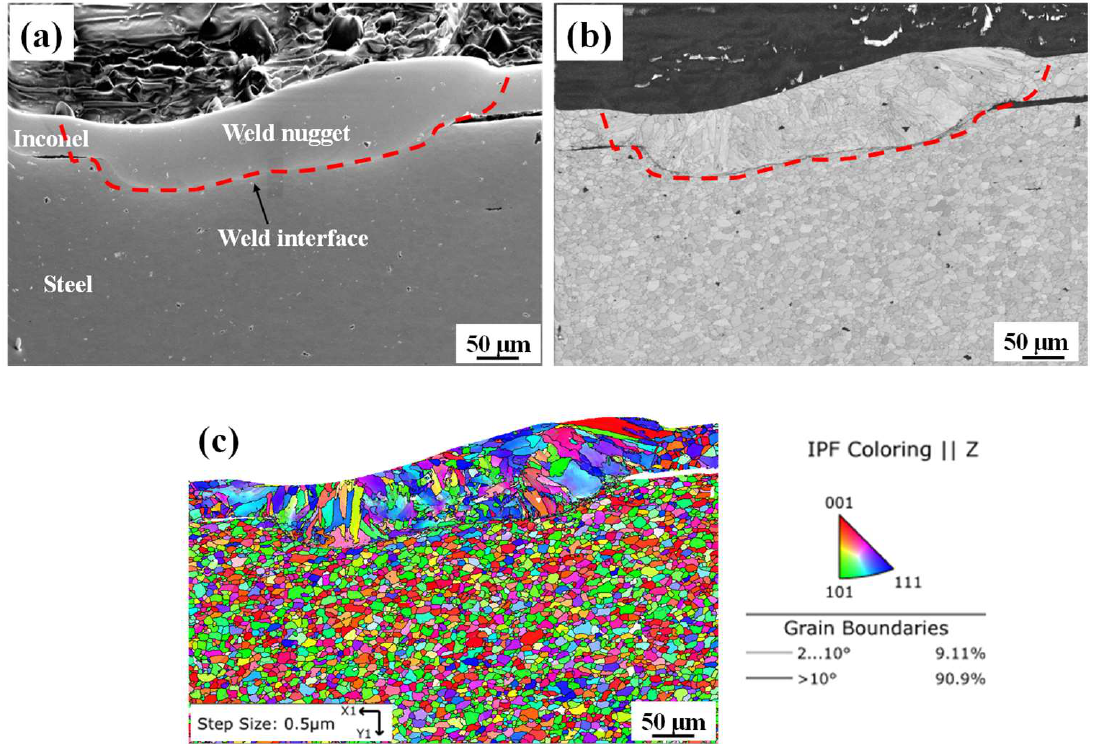
Figure 8. ( a ) SEM micrograph, ( b ) band contrast map and ( c ) EBSD map with IPF colouring of laser-welded joint interface at good-weld